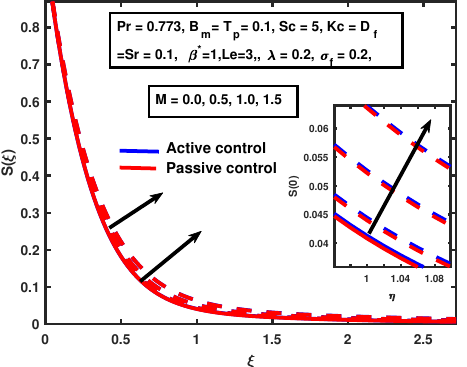
Figure 11. The impact of S ( ξ ) on magnetic M .